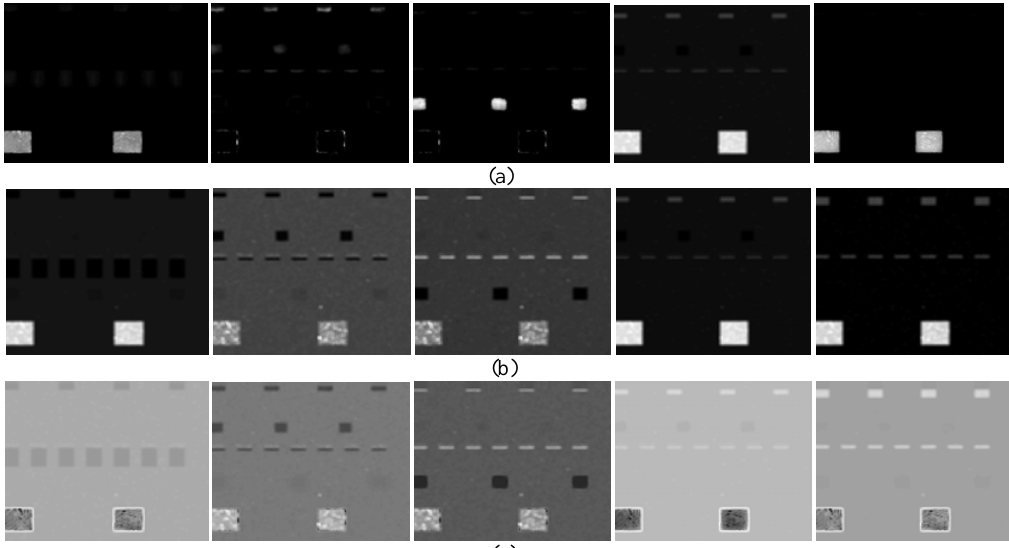
Figure 5. Change detection maps (a) RKL change maps (b) RDR change maps (c) DSMT fusion results.